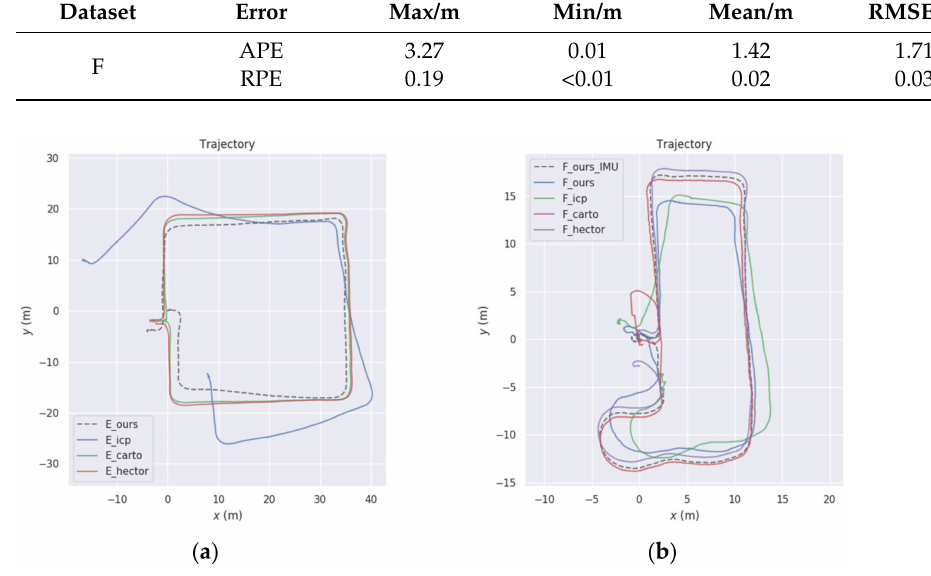
Figure 7. Trajectories for datasets E and F. ( a ) The trajectory of scene E, ( b ) The trajectory of scene